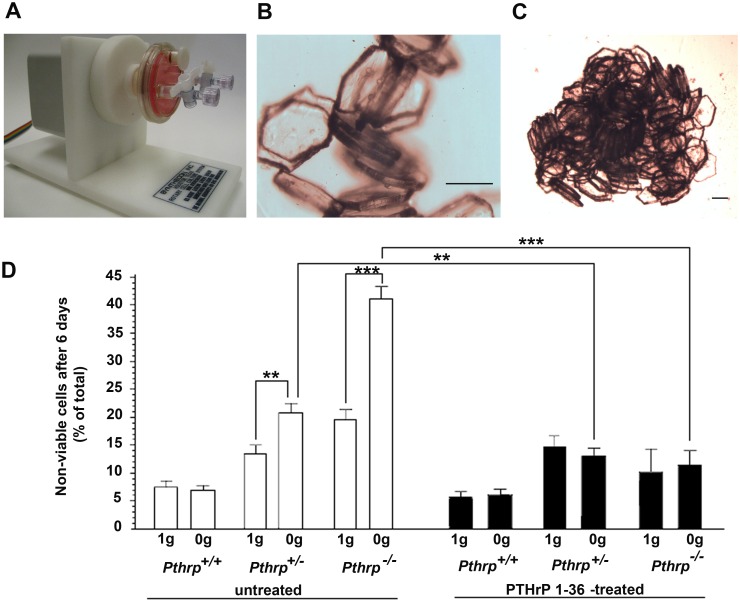
Allelic effect of endogenous PTHrP levels in simulated microgravity, and compensation by exogenous PTHrP 1–36 (6-day experiments).(A) Microgravity simulation apparatus (RCCS) with one rotating culture unit (HARV). (B) MicroHex carriers with attached trabecular osteoblasts in culture. (C) Cell-induced MicroHex aggregate in culture (occurs for both trabecular and calvarial osteoblasts). (D) Trabecular osteoblast viability after 6 days on MicroHex carriers in normal gravity (1g) or in simulated microgravity (0g) (triplicate 6-day experiments). White bars: untreated; black bars: 2-h daily treatment with PTHrP1-36 10-8M. ** p < 0.01, *** p < 0.001. Scale bars: B, C: 200 μm.